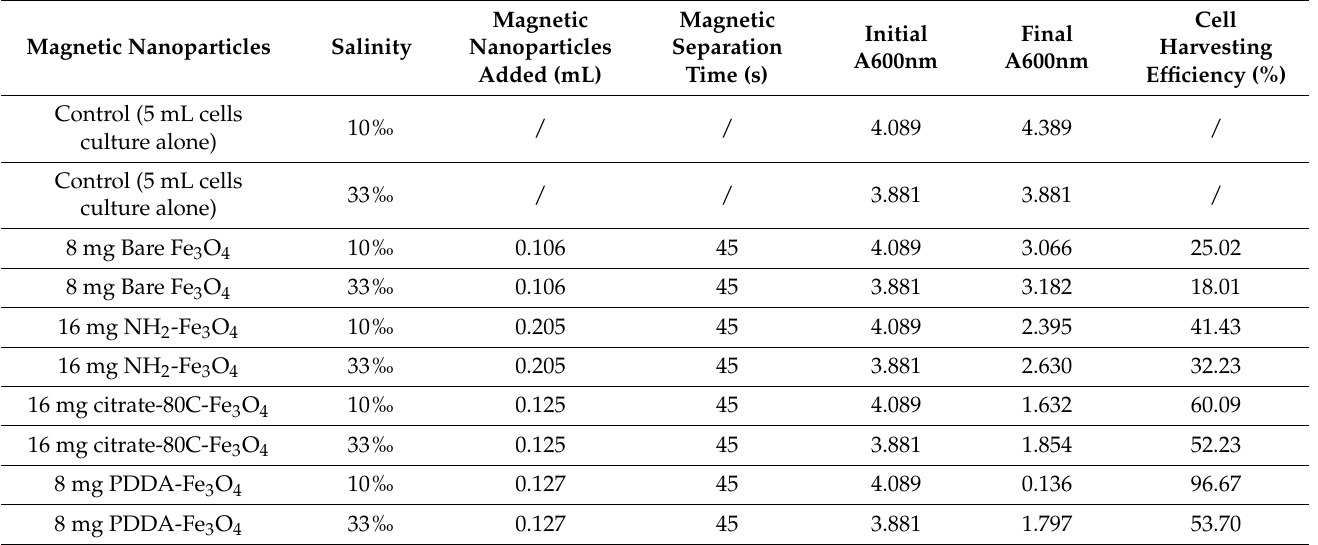
The results showed that in the presence of 10‰ salinity, PDDA ‐ Fe